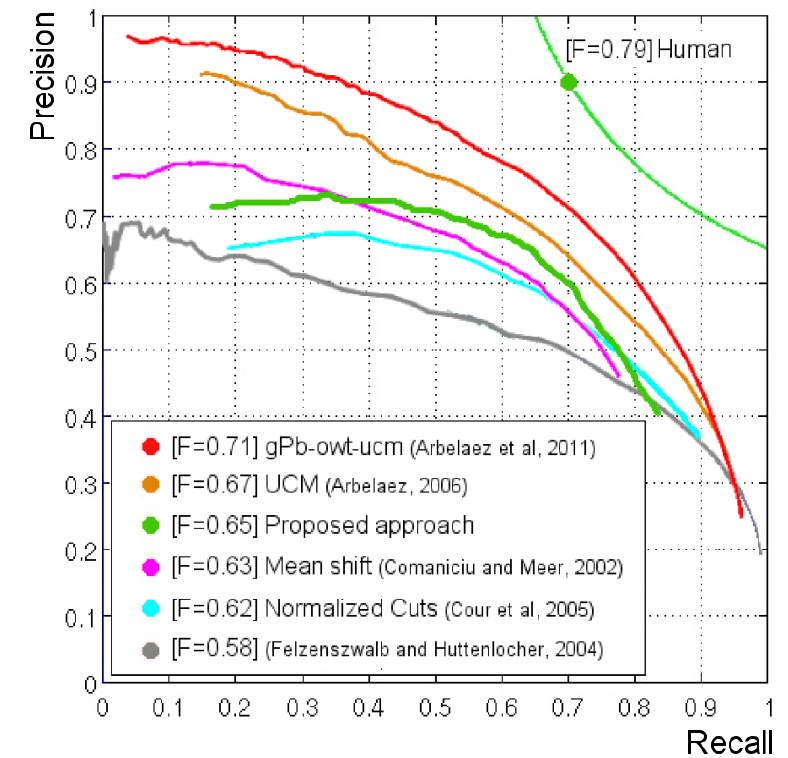
Figure 15. Comparison of our segmentation proposal with other approaches. The data to compute the precision-recall curves for these other approaches have been downloaded from